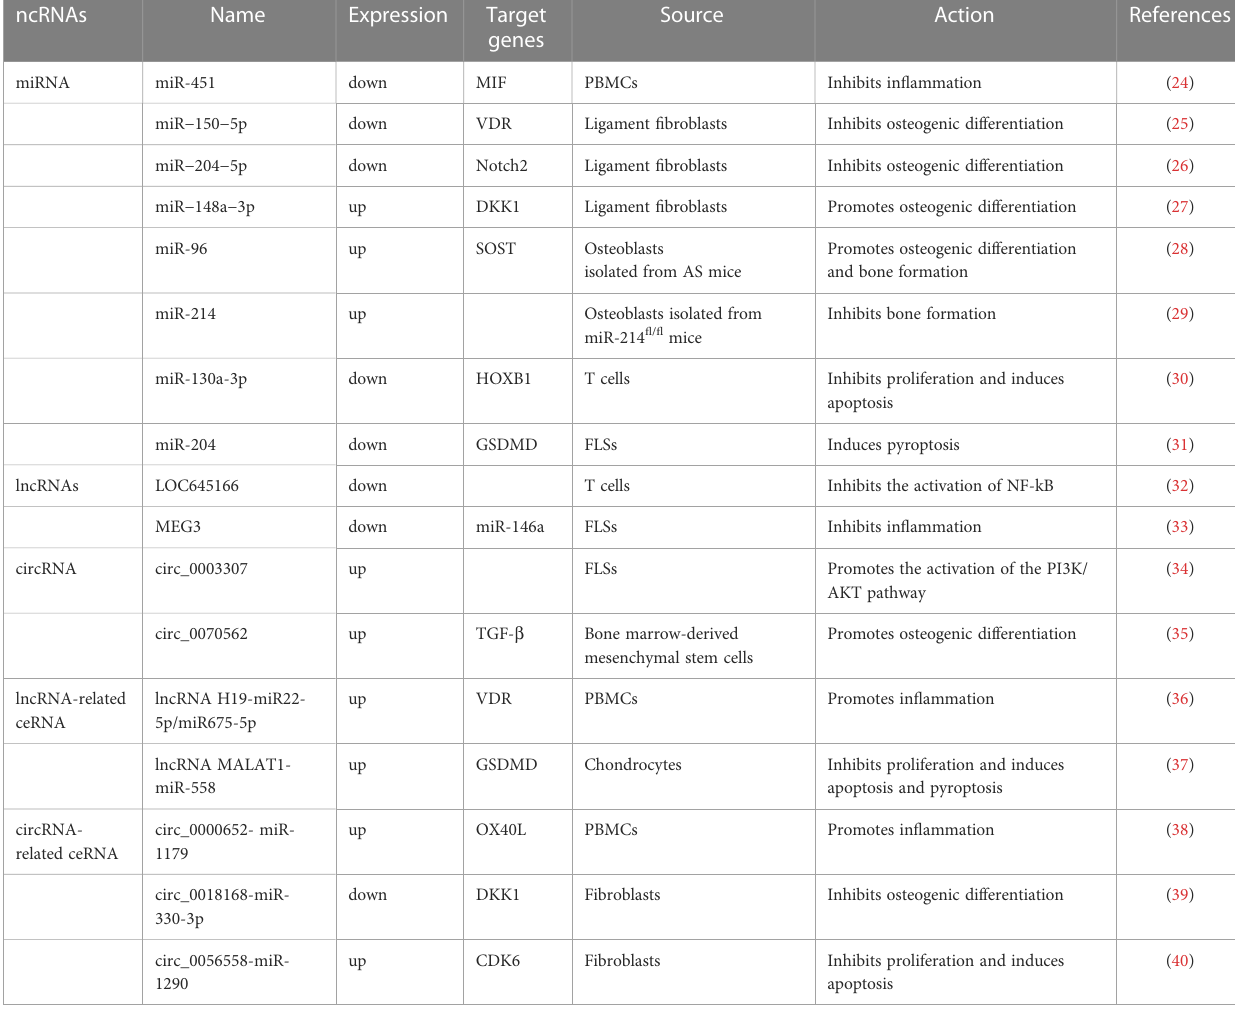
TABLE 1 Regulatory functions of ncRNAs in ankylosing spondylitis cells.